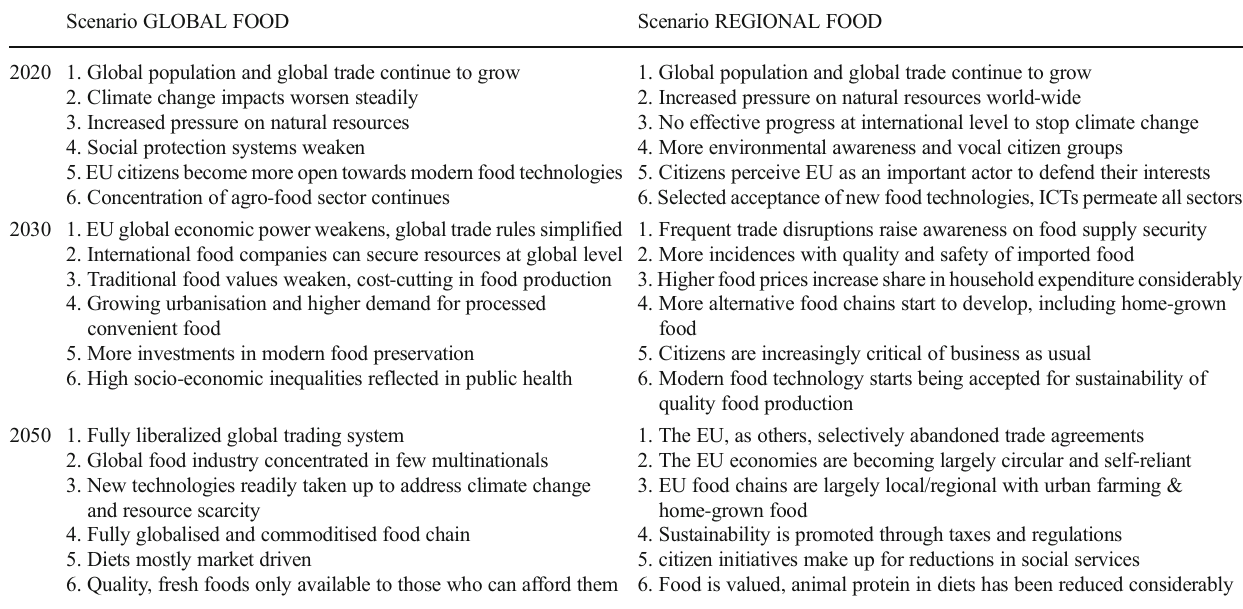
Timeline of the stories used to explore the scenarios Global Food and Regional Food with the SES Scenario GLOBAL FOOD Scenario REGIONAL